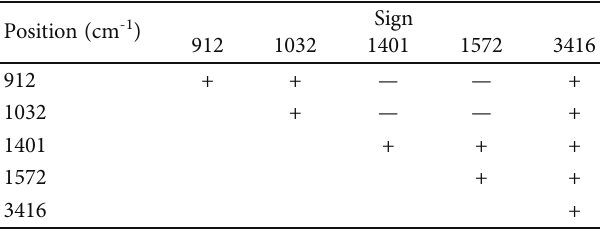
Table 3: Signs of each cross peak in the synchronous ( Ф ) and asynchronous ( Ψ )